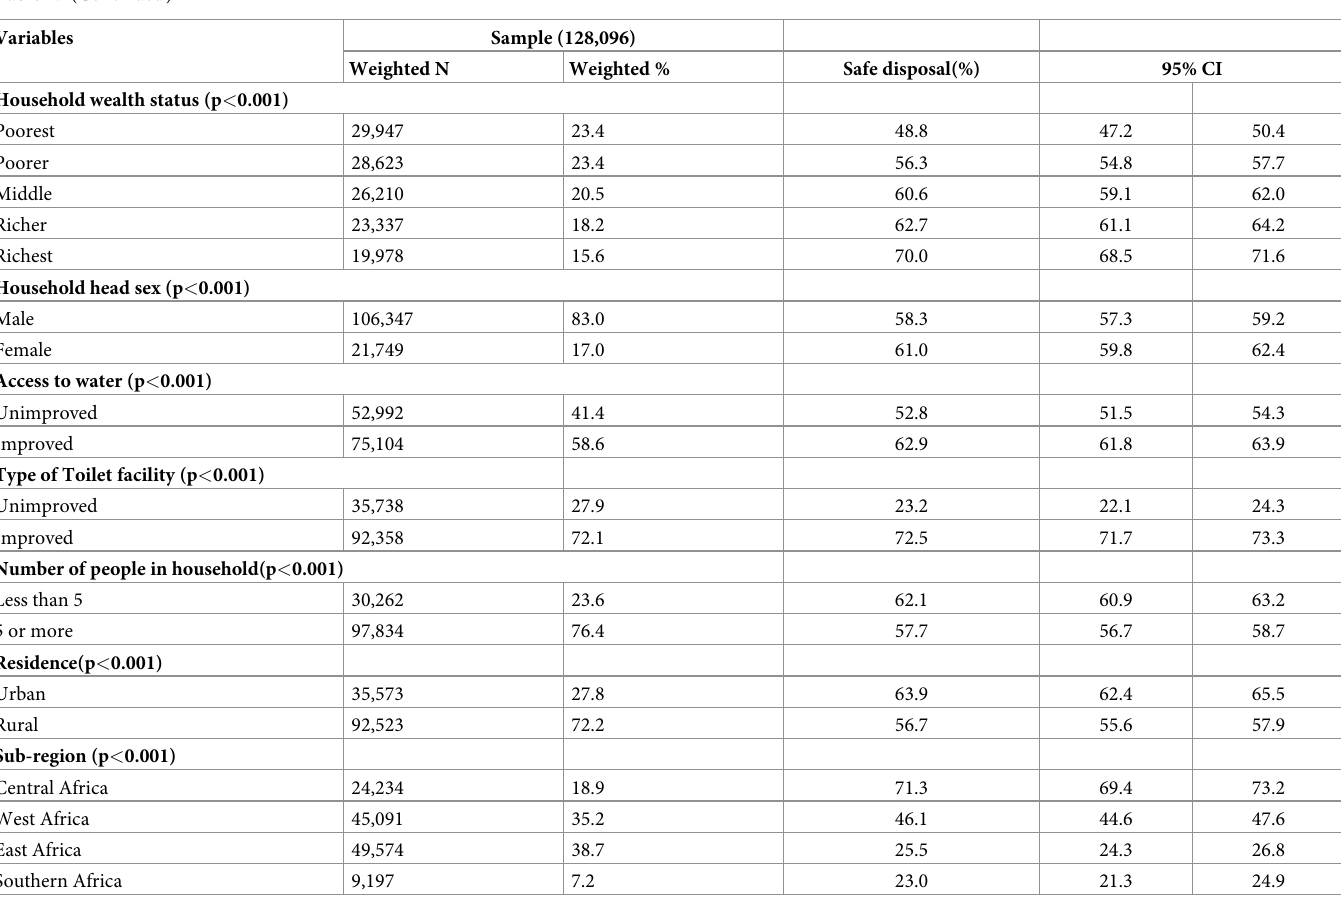
Fixed effects results. Table 3 shows the results of the multilevel logistic regression analy- sis. The final model (Model 3) is the complete model that shows how the individual